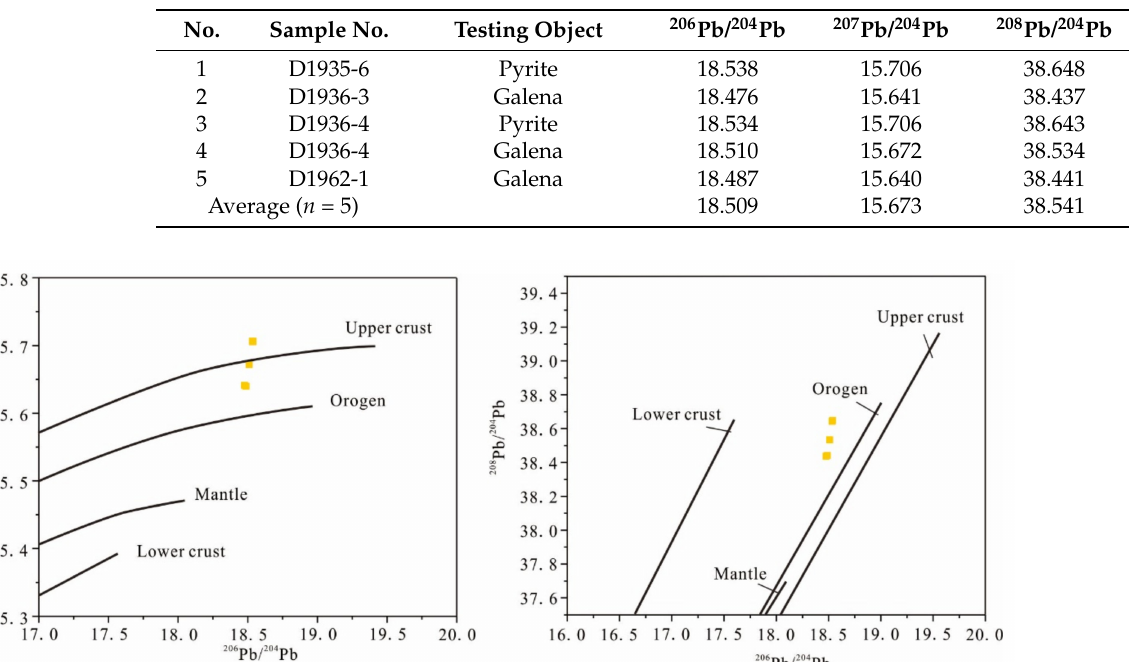
Table 4. Lead isotope ratios of ores and rocks at the Juyuan tungsten deposit.